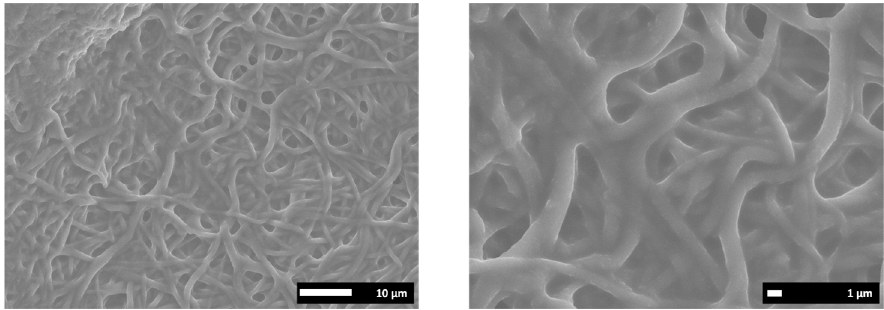
Figure 8. SEM pictures for the polymeric mat 11 (scale bars correspond to 10 μ m ( left ), 1 μ m ( right )).